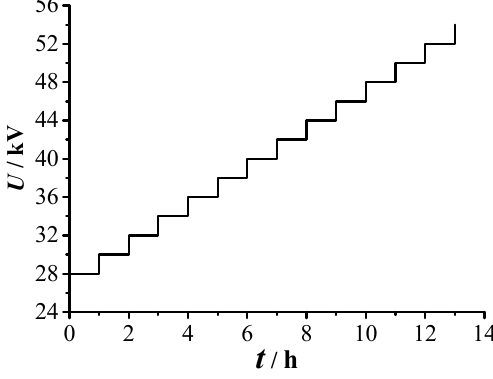
Figure 5. Experimental voltage and duration.